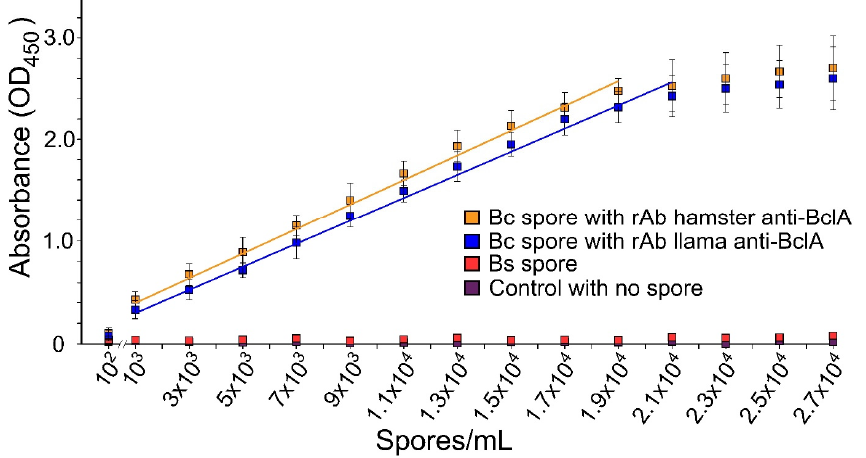
Figure 2. Analysis with ELISA for selectivity and sensitivity of rAbs. A sandwich ELISA strategy was conducted to determine the range of detection sensitivity of the hamster and llama anti-BclA rAbs (rAb3 and rAb4). This experiment was repeated thrice. Error bars represent standard deviations. Trend lines are shown to highlight the linear range of detection. Abbreviations: Bc, Bacillus cereus ; Bm, Bacillus megaterium ; Bs, Bacillus subtilis .